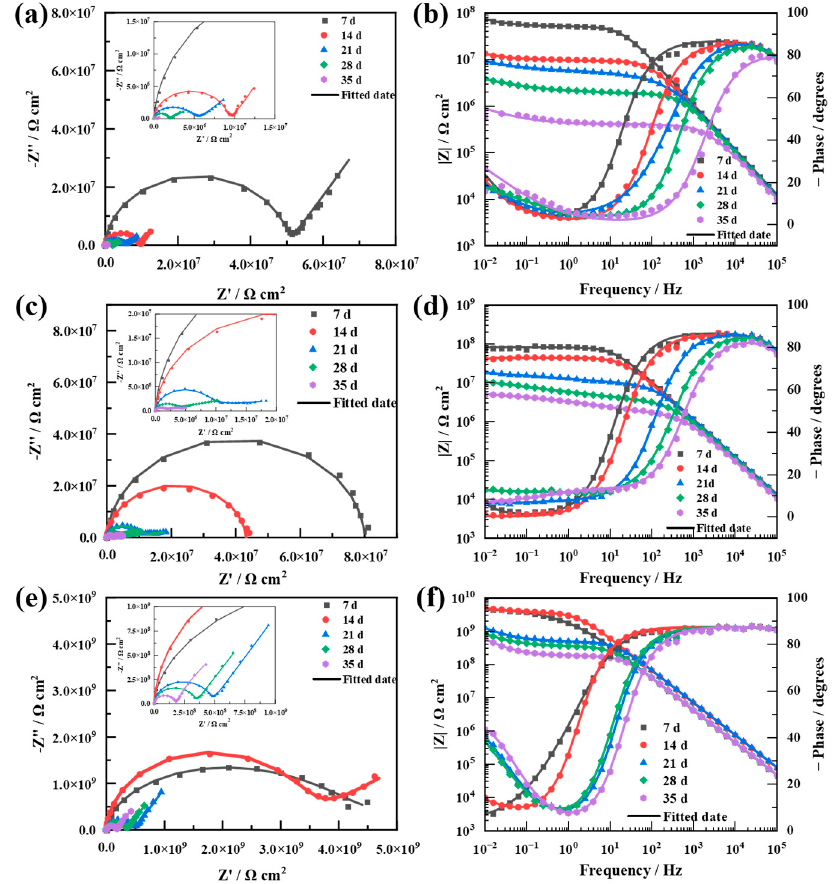
Figure 9. ( a , c , e ) Nyquist and ( b , d , f ) Bode plots of ( a , b ) pure EP; ( c , d ) LDH/EP; and ( e , f ) GA − LDH/EP coatings coated on Q235 steel.(The insets in ( a , c , e ) are Nyquist plots of the respective magnified high-frequency regions.).